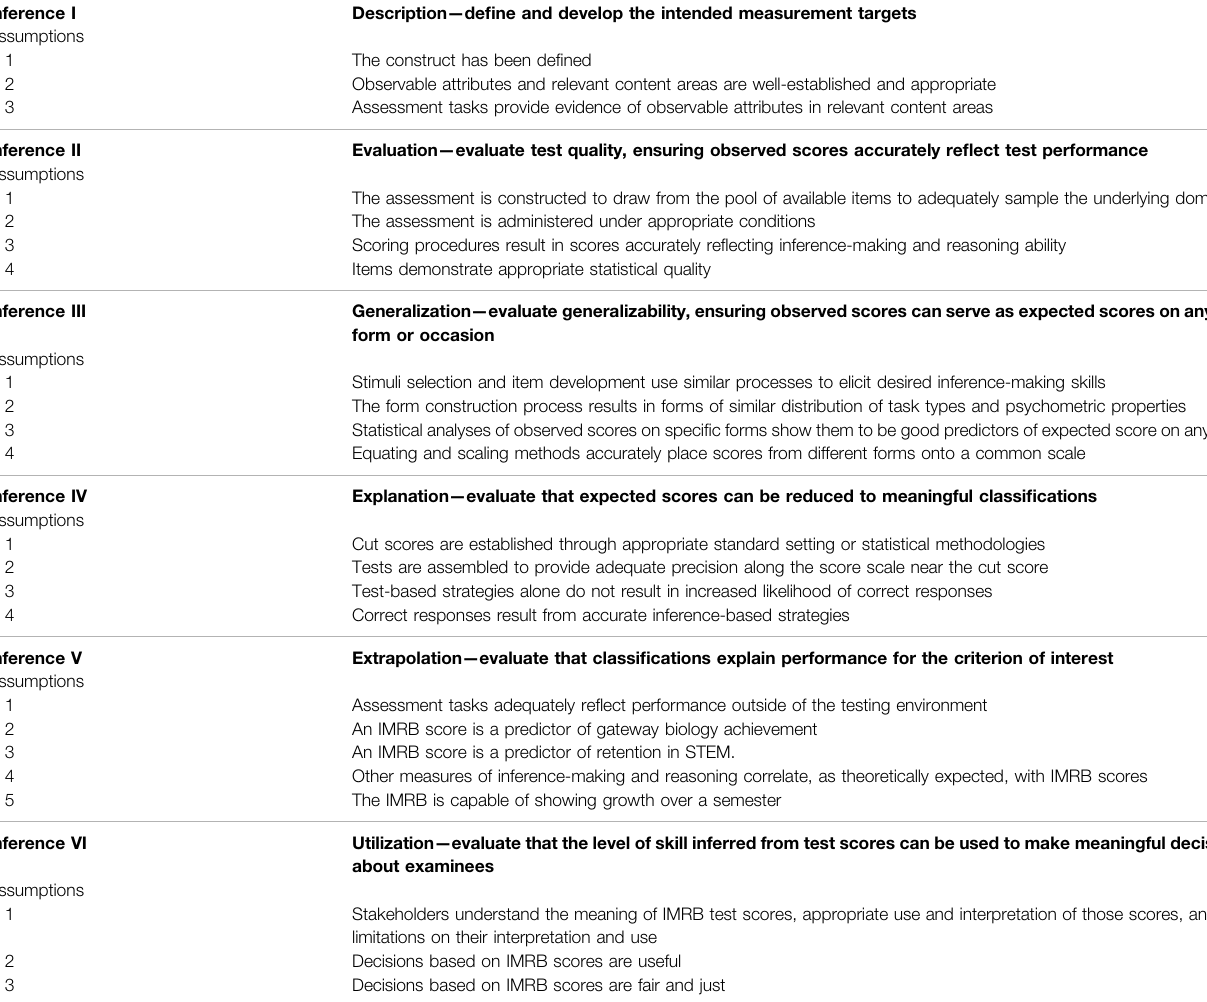
TABLE 2 | Framework for developing the validation argument — inferences and